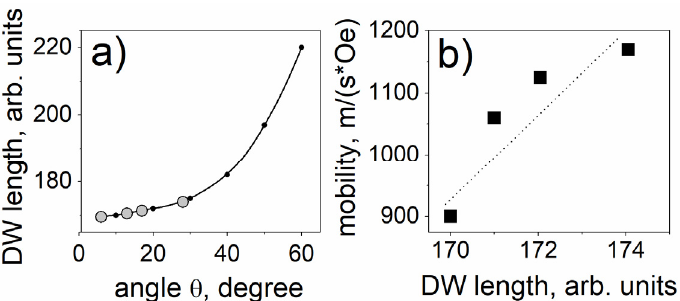
Figure 14. Dependence of DW length of angle of inclination ( a ) and dependence of mobility on DW length in spiral domain wall. ( a ) Line—results of the calculation, points taken from the experiments. ( b ) experimental points. Reprinted with permission from [99].